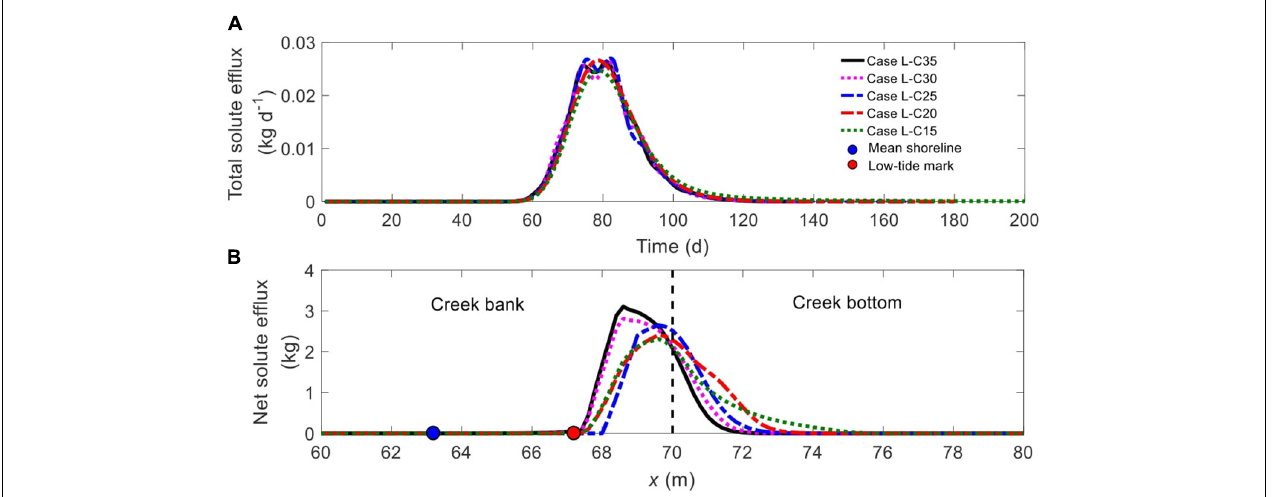
FIGURE 9 | Comparison of (A) time-dependent total solute efflux and (B) spatial distribution of net solute efflux across the SWI (BCDE in Figure 1 ) for different ratios of C sea / C pore . The blue and red nodes in panel (B) represent the mean shoreline and low-tide mark, respectively, while the vertical dashed line separates creek bank (left) and creek bottom (right).